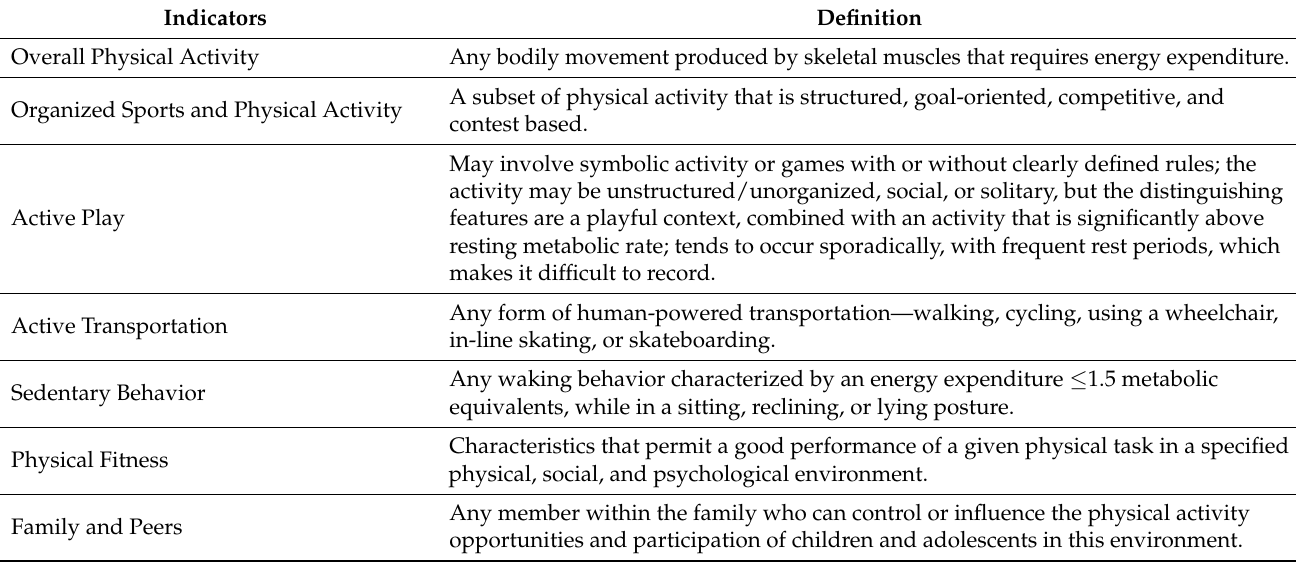
Table 1. Global Matrix 4.0 indicators of success in promoting physical activity 1